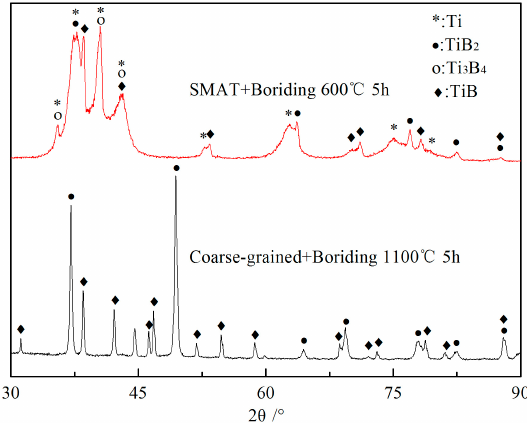
Figure 5. XRD patterns of the borided layer of the SMAT sample and coarse-grained sample.